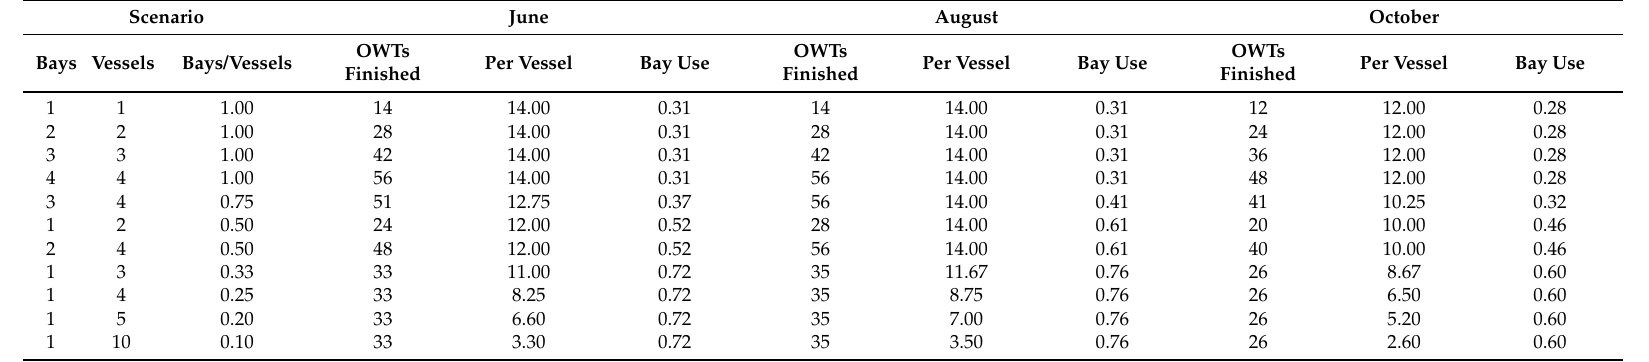
Table 5. Results for different combinations of vessels and loading